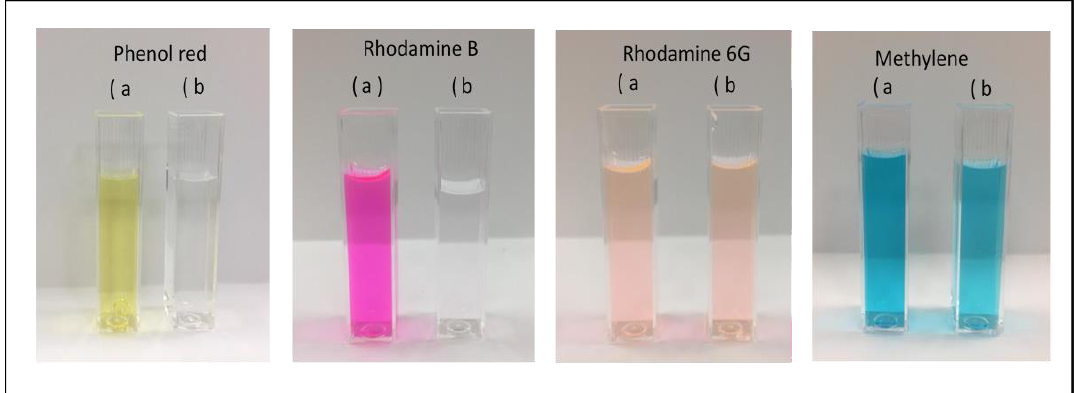
Figure 2. The color of 5 mL solutions of 10 ppm phenol red, rhodamine B, rhodamine 6G, and methylene blue before filtration (a) and after filtration (b).